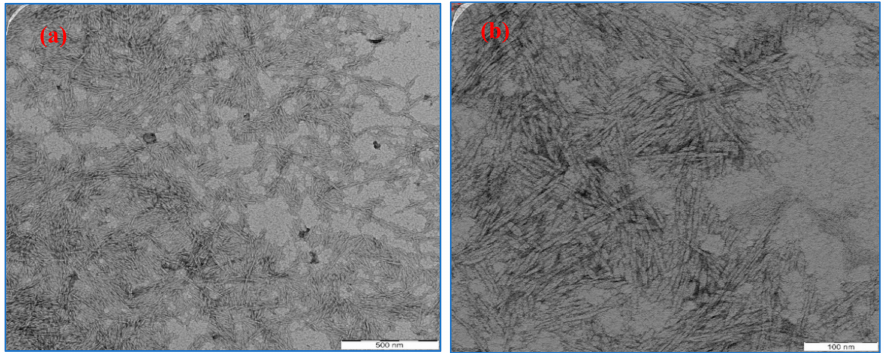
Figure 4. TEM micrographs of OPEFB-CNF. ( a ) 50,000 × magnification; ( b ) 100,000 ×